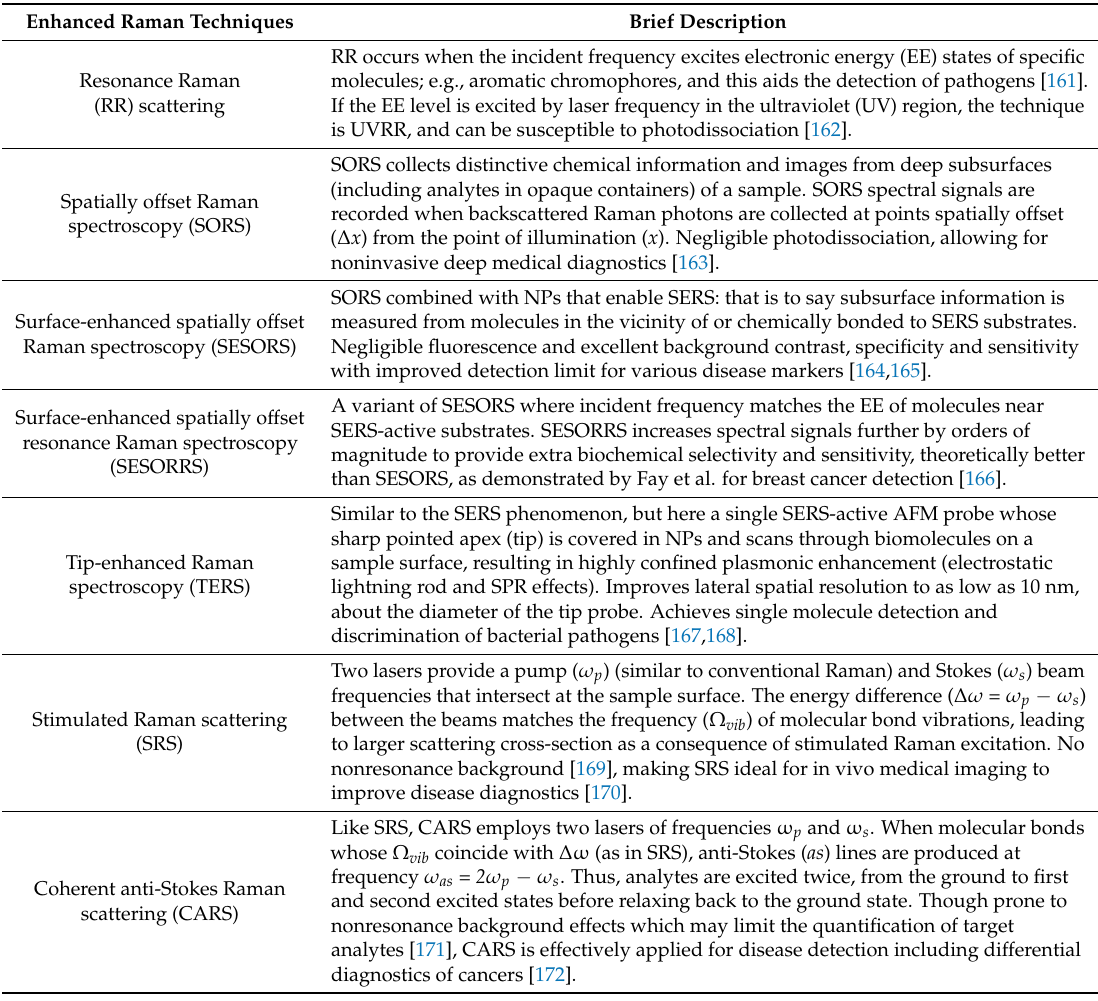
Table 1. A summary of different types of enhanced Raman scattering techniques commonly used in disease